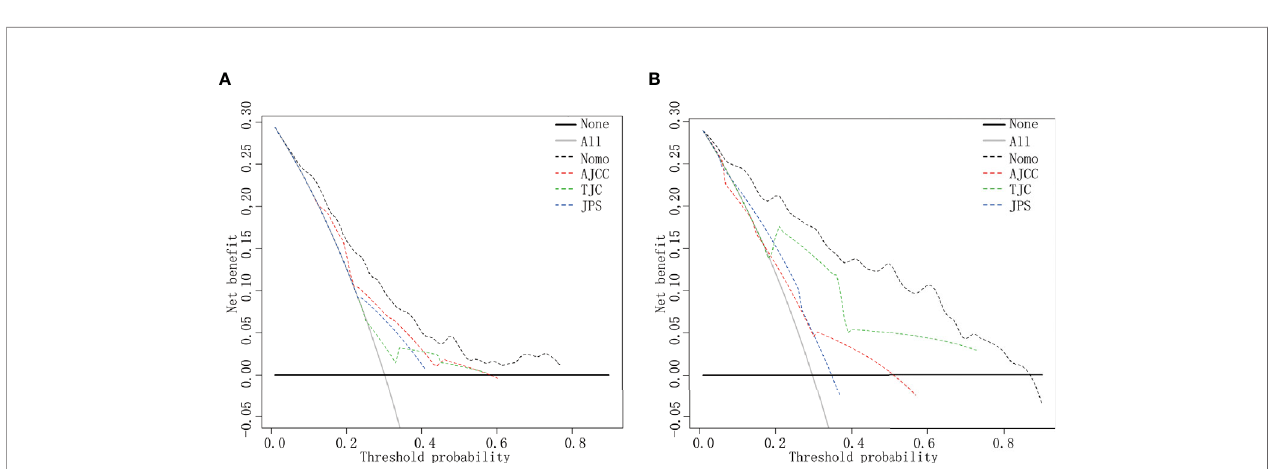
FIGURE 4 | DCA curves. DCA curves in the training cohort (A) and the validation cohort (B) . Clinical usefulness of different predictive systems in predicting overall survival at various time points. The y -axis represents net bene fi t. The x -axis shows threshold probability. The black dotted line displays the bene fi t of the developed nomogram. The red dotted line displays the bene fi t of the AJCC stage. The green dotted line displays the bene fi t of Tongji classi fi cation, and the blue dotted line displays the JPS stage. Nomo, the developed nomogram model.